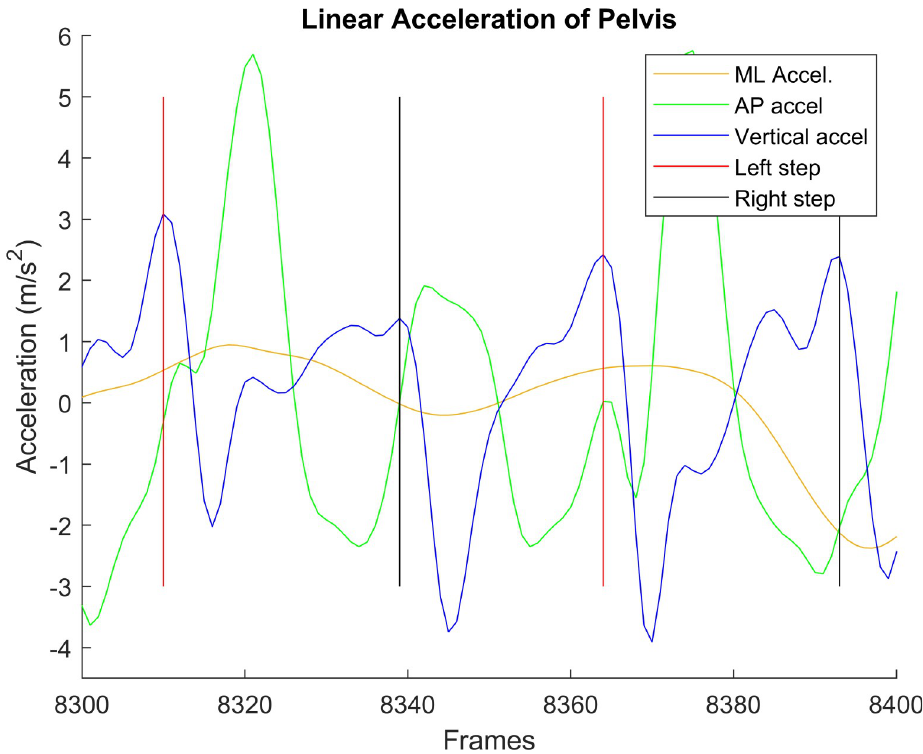
Fig 4. Anterior-posterior (blue), vertical (green), and medial-lateral (yellow) accelerations after manual step identification. Black lines indicate right steps, red lines indicate left steps.